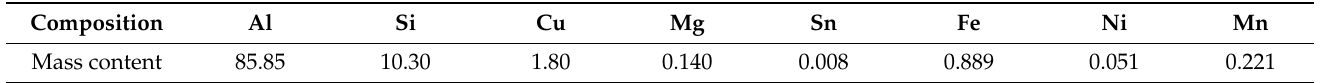
Figure 2. The die mold and injection chamber installed on a die-casting machine: ( a ) ejector die and cover die of the die mold, and ( b ) cold chamber and piston. Table 1. The composition of the cast aluminum alloy ADC12.